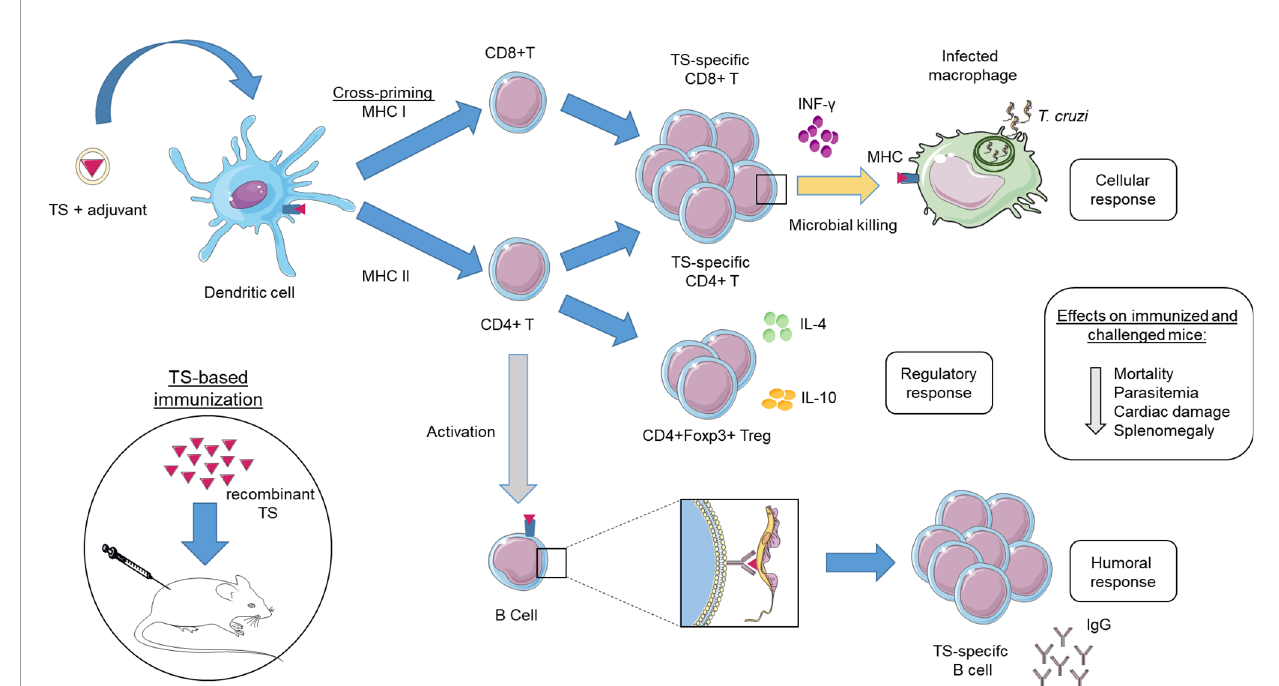
FIGURE 2 | Immune response model for trans -sialidase (TS)-based vaccines. In the immunization of mice with vaccines based on recombinant TS, exogenous antigens are usually processed and presented by antigen presenting cells (APC) via MHC class II, recognized by CD4 T cells. This pathway will stimulate B cells to produce and secrete TS-speci fi c antibodies (Humoral response). Certain types of APC such as dendritic cells can process and present exogenous antigens via MHC class I, recognized by CD8 T cells, a process known as cross-priming. Both TS-speci fi c CD8 and CD4 T cells can differentiate into cells with cytotoxic activity capable of killing Trypanosoma cruzi -infected cells as macrophage (Effector response). In addition, a group of speci fi c-TS CD4 T cells (Foxp3) known as regulatory T cells are responsible for controlling the pro-in fl ammatory response in the host (Regulatory response). The immunization of animals with vaccines based on TS has reduced parasitemia, tissue damage and consequently the mortality